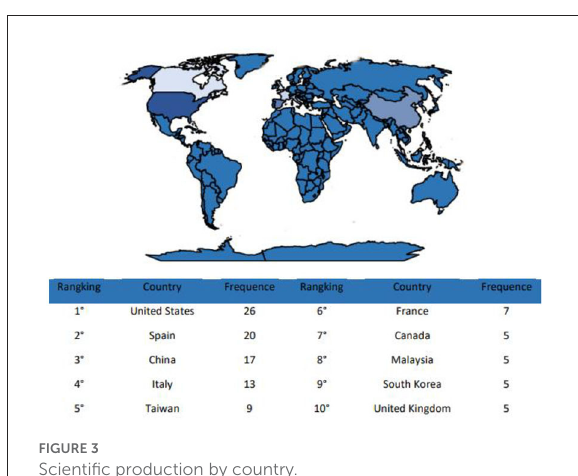
FIGURE3 Scientific production by